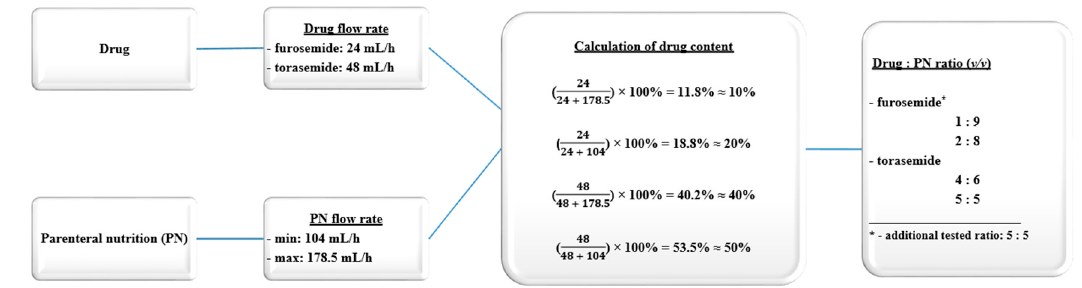
Figure 1. Calculation of the sample